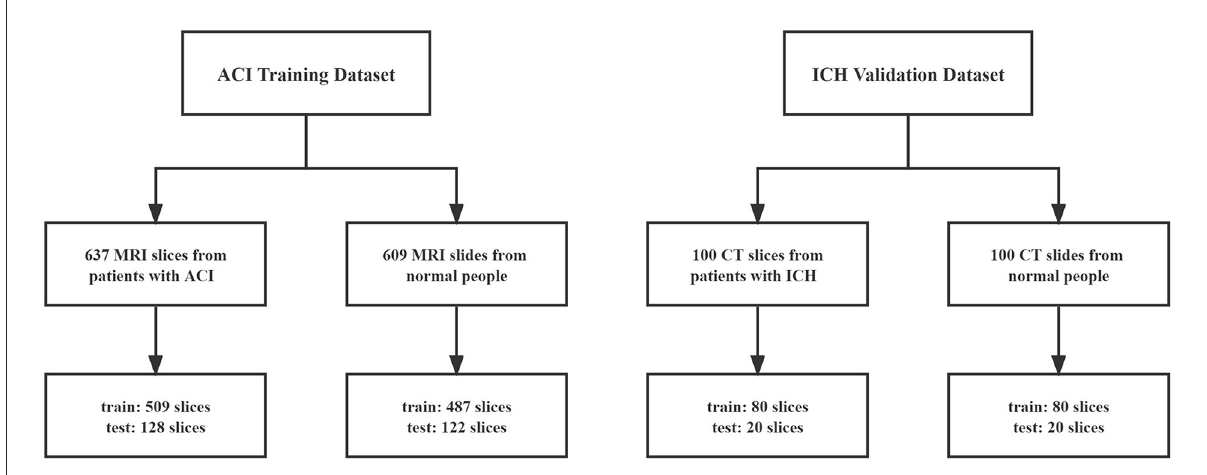
FIGURE1 Composition of ACI training dataset and ICH validation dataset.